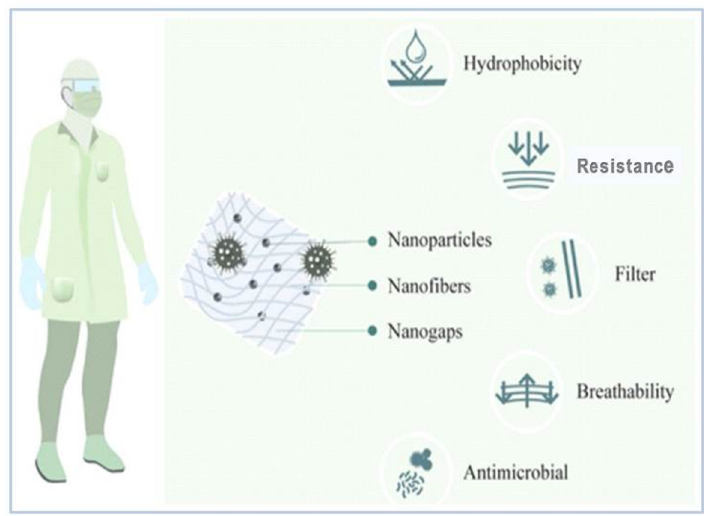
Figure 2. Nanotechnology applications for preparation of PPE Kit [36].